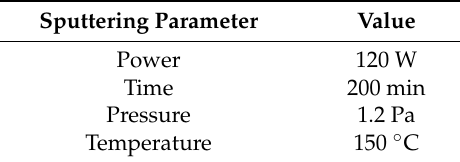
Table 2. Sputtering parameters.